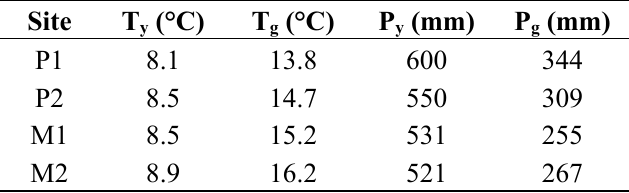
Table 3. Climatic characterization of forest sites on the base of permanent climate stations (T y = yearly average temperature, T g = growing season (April–September) average temperature, P y = average annual sum of precipitation, P g = growing season (April–September) average sum of precipitation.